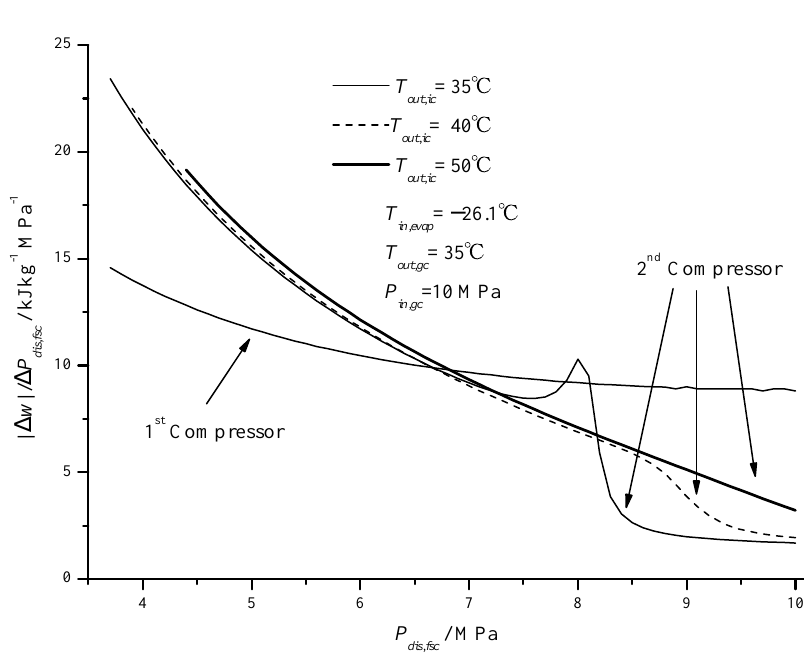
Figure 13. Variations of 1st and 2nd specific compression works at various intercooler outlet temperatures.